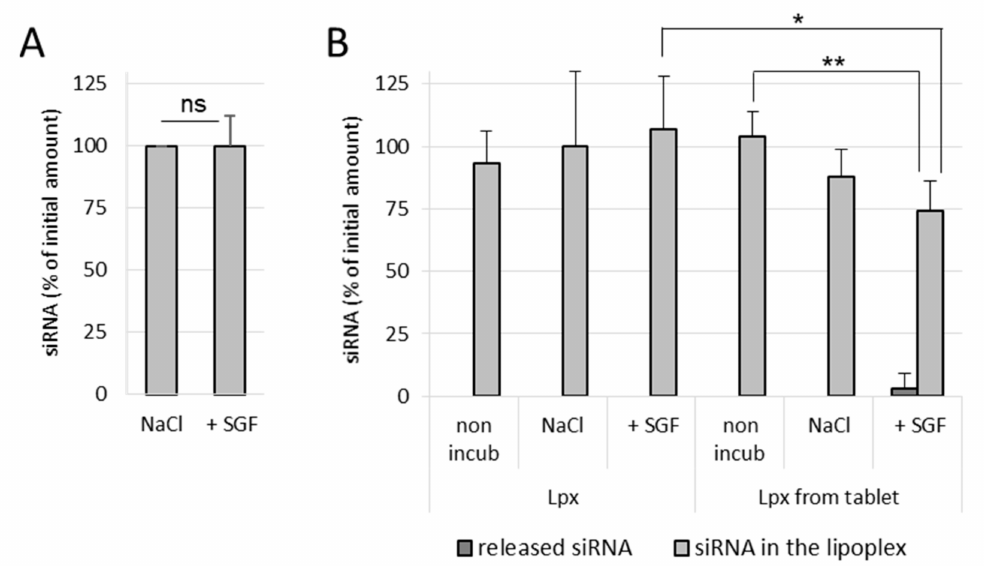
Figure 4. Effect of NaCl (150mM) and simulated gastric conditions on the stability of naked siRNA ( A ) and siRNA lipoplex ( B ). ( A ) Naked siRNA was incubated in NaCl or SGF for 1 h at 37 ◦ C, before being assayed by gel electrophoresis. ( B ) siRNA lipoplexes freshly prepared (Lpx) or